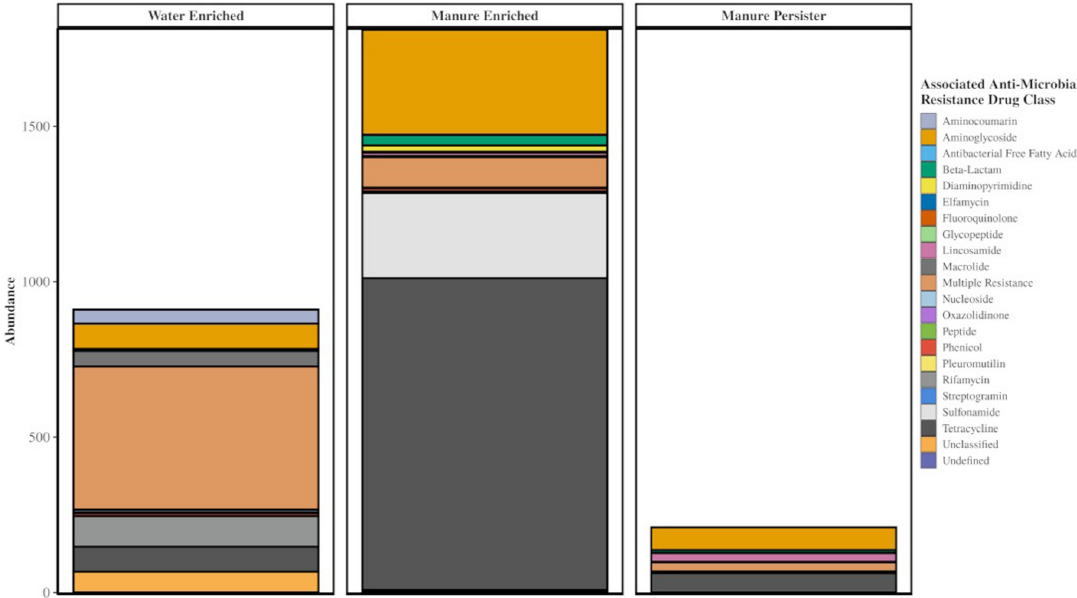
Fig 6. Abundance of ARGs observed in manure-treated effluent samples, summed across all sampling days. Abundance normalized by number of recA genes present. “Multiple Resistance” for ARG classification refers to any gene that has been annotated as associated with more than a single antibiotic